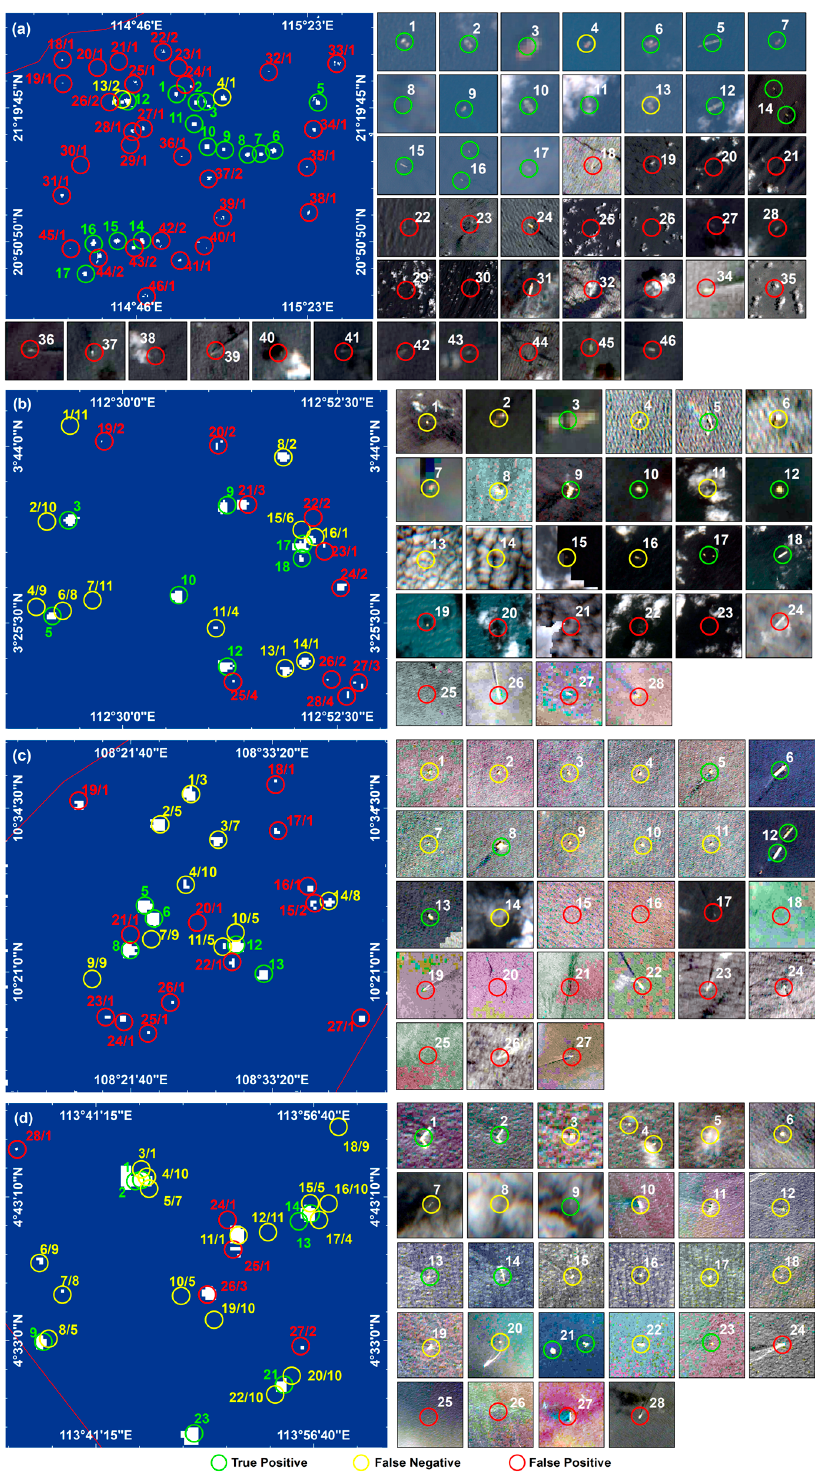
Figure 7. Extraction results of the targets in region 3, located in the Mekong Basin: ( a – f ) are the ex- traction results in 2016; ( g – l ) are the extraction results in 2017. Red arrows are the validation tar- gets; green circles are the correctly extracted targets; yellow circles are the omissive targets; and red circles are the incorrectly extracted targets.